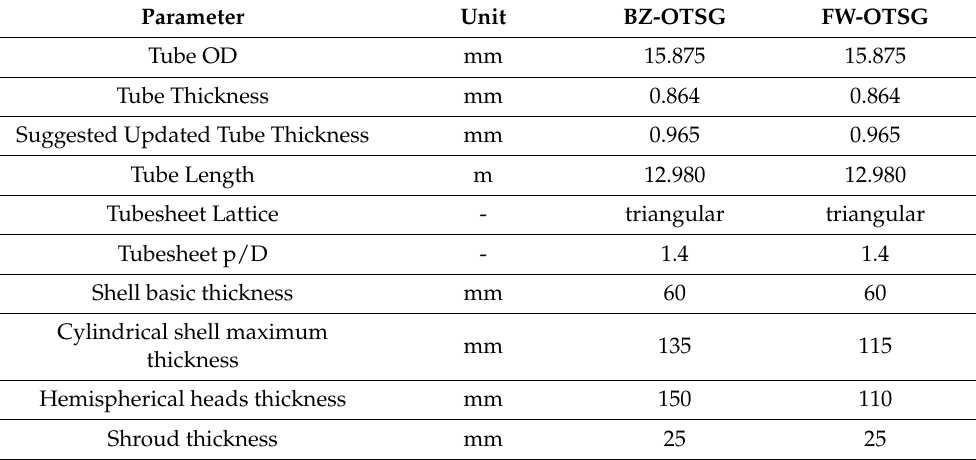
Table 3. BZ and FW OTSG main geometrical data with small adjustments after mechanical